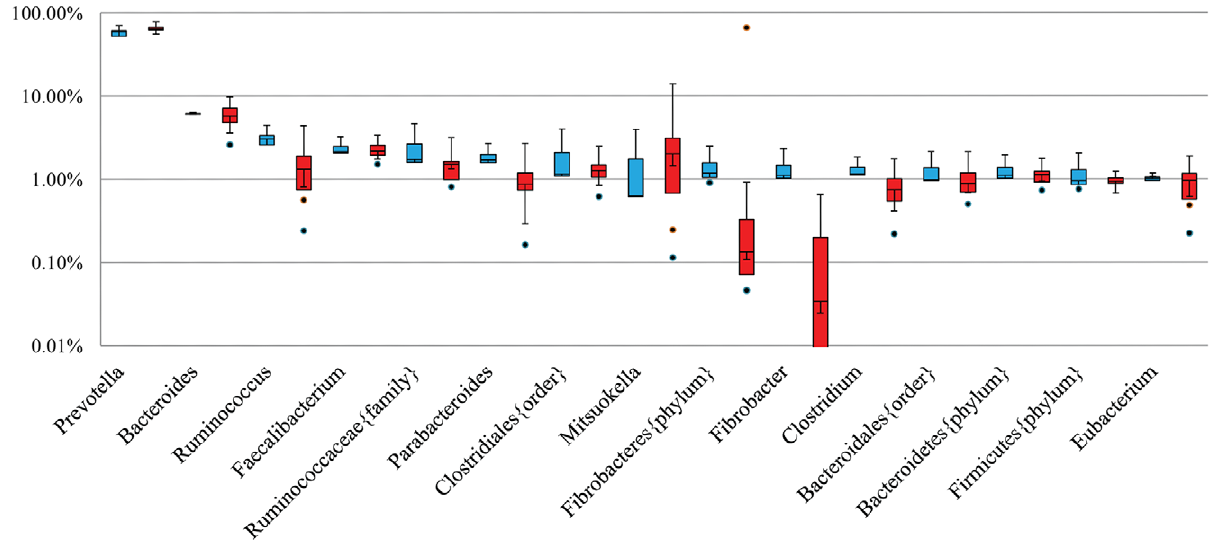
Figure 3. Relative abundance of 15 genera in the porcine proximal colon microbiota detected using MetaPhyler. Boxes denote the inter-quartile range between the 1 st and 3 rd quartiles (25 and 75%, respectively). Blue: Parasite naı¨ve pigs ( N =3); Red: Infected pigs ( N =8). Symbol {} denotes a possible novel genus within the taxon indicated. For example, Ruminococcaceae{family} indicates a possible novel genus within the family Ruminococcaceae. A significant repression of relative abundance of the genus Fibrobacter and a possible novel genus in the phylum Fibrobacteres was detected in the proximal colon microbiota of Trichuris suis infected pigs. Y-axis: log scale.